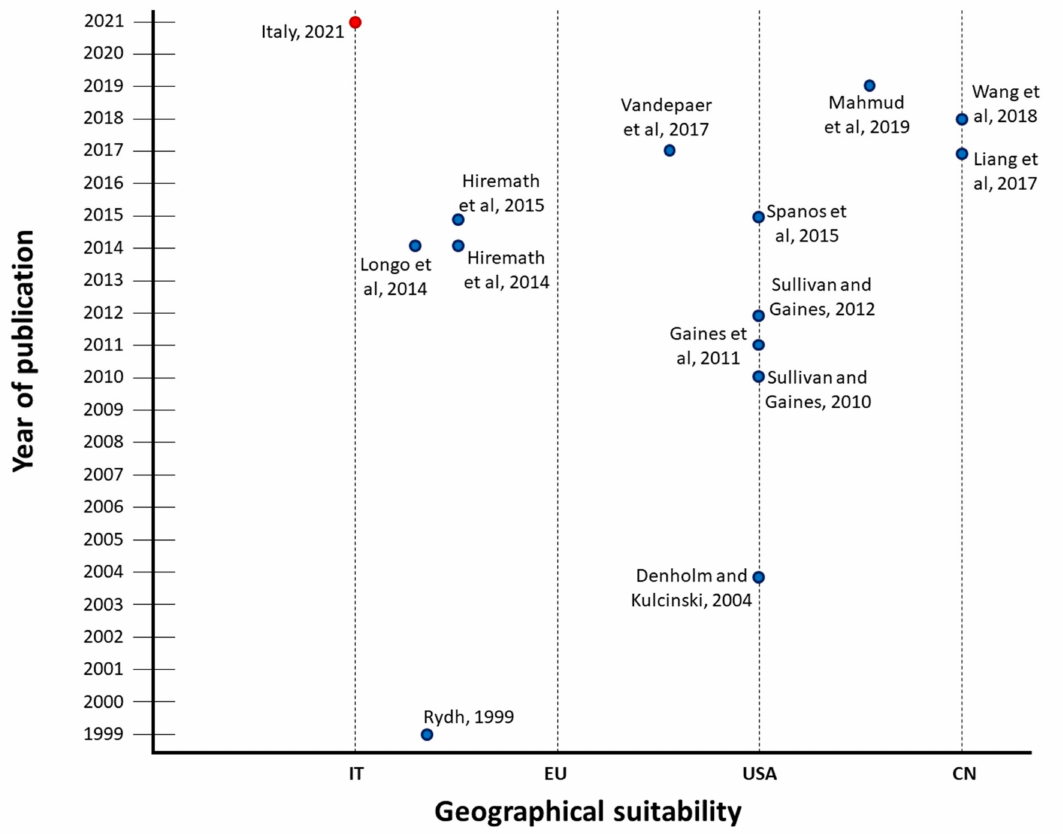
Figure 1. Geographical and temporal distribution of life cycle assessment (LCA) studies on stationary batteries. (Italy, 2021: the present study; IT: Italia; EU: Europe; USA: United States of America; and CN: